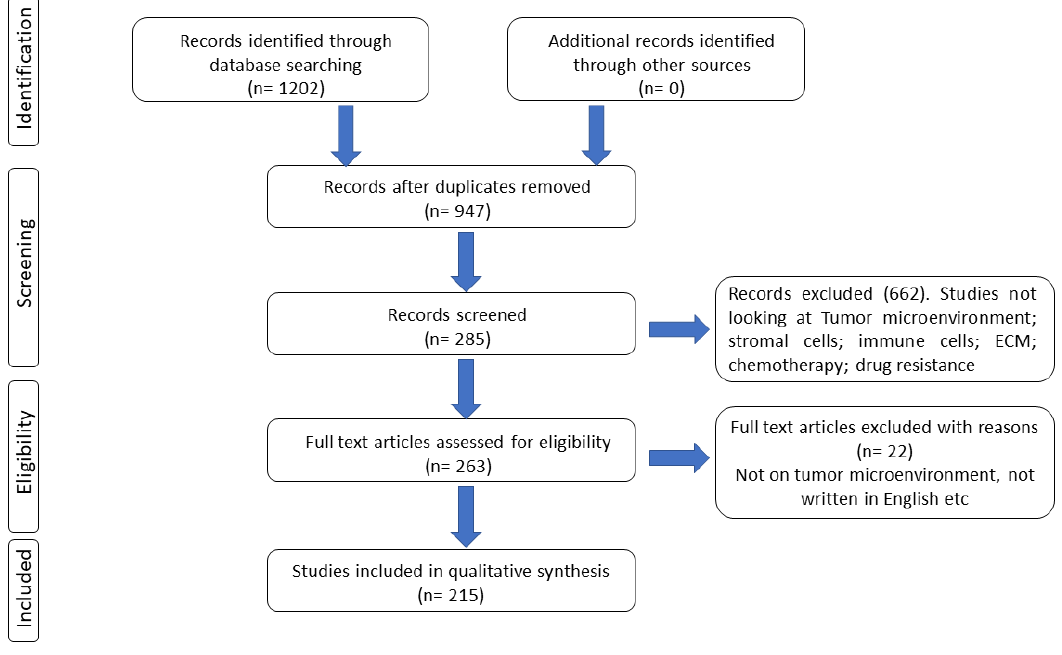
Figure 1. Selection of manuscripts used in the production of this review manuscript.